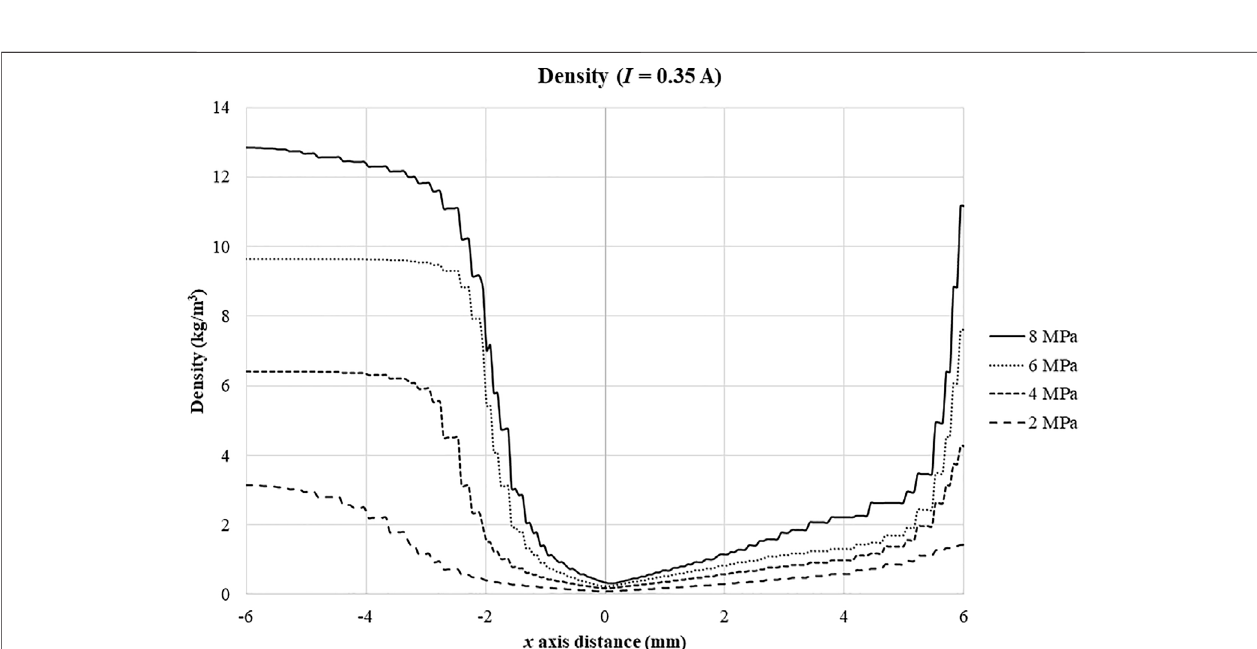
FIGURE 4 | Density in the x axis direction at the center of the inter-electrode gap ( t (cid:2) 50 ms, I (cid:2) 0.35 A).